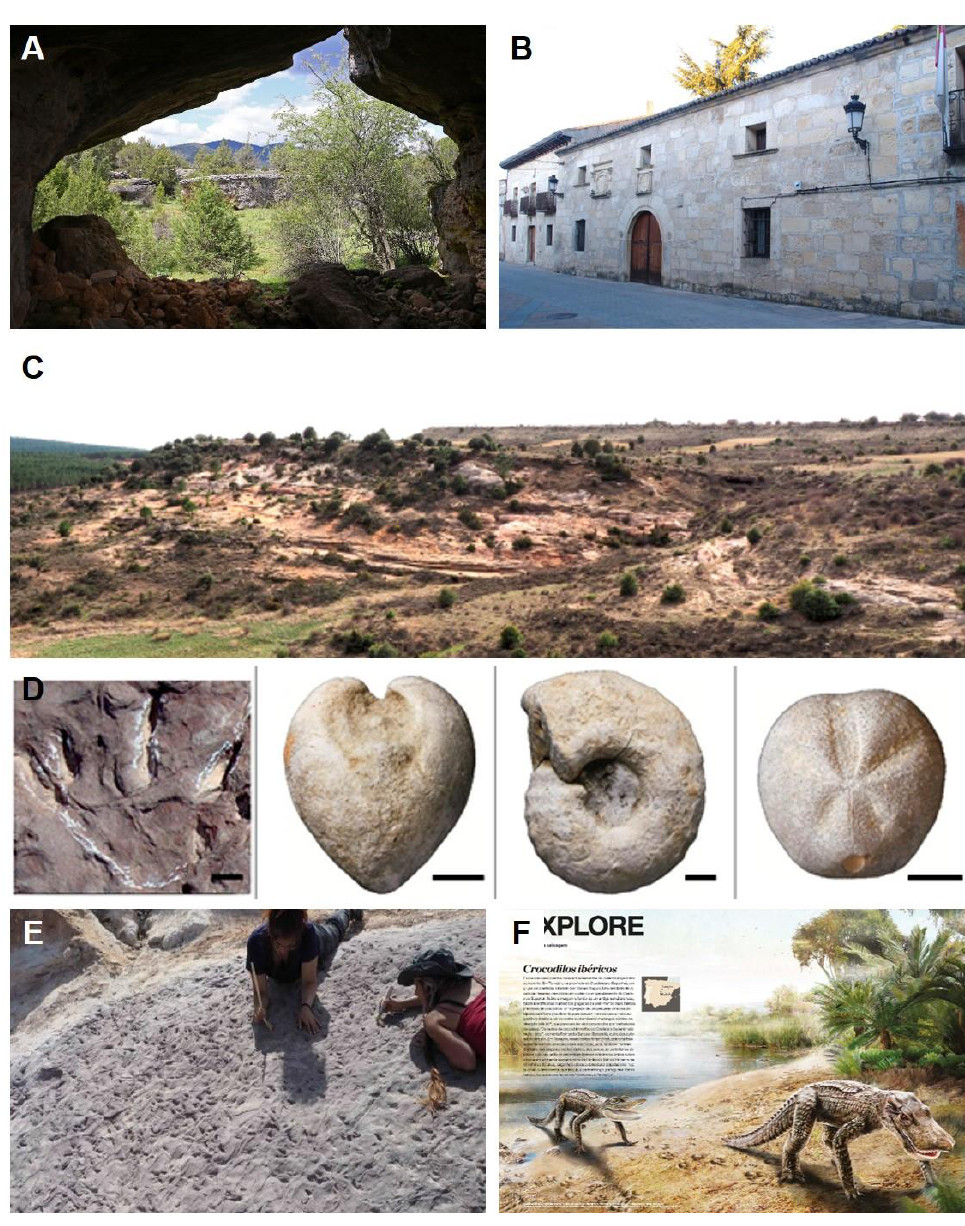
Figure 2. ( A ) Photographic view from the inside of a karstic hollow of the “Ciudad Encantada” of Tamajón (Guadalajara, Spain), where important paleontological and archaeological discoveries have been made; ( B ) View of the “Palacio Mendocino”, a palace in Renaissance style and with a 16th century Plateresque facade, with a vaulted semicircular arch entrance and noble coats of arms carved in Tamajón Stone, which is currently used as the town hall; ( C ) Panoramic view of the Upper Cretaceous of Tamajón, where paleontological outcrops include several levels rich in fossil plants, numerous invertebrates and some vertebrates; ( D ) Fossils from the Upper Cretaceous site of Tamajón. Ichnite (fossil footprint) corresponding to a foot of the main crocodylomorph track (left). Lateral view of a mold of a bivalve Granocardium ( Granocardium ) productum (centre, left). Lateral view of an ammonoid Spathites ( Jeanrogericeras ) saenzi (centre, right). Apical view of an echinoid Hemiaster bufo (right). Graphic scales: ichnite: 2 cm, bivalve and ammonoid: 1 cm, echinoid: 0.5 cm; ( E ) Image of the track surface discovered by Professor Manuel Segura of the University of Alcalá, with traces of crocodylomorphs, a theropod dinosaur and fishes, during the process of preparation and study during July 2018; ( F ) Image of the report “Crocodilos Ibéricos” about the Cretaceous fossil footprints of Tamajón, published in May 2016 in the Portuguese edition of the National Geographic Journal .